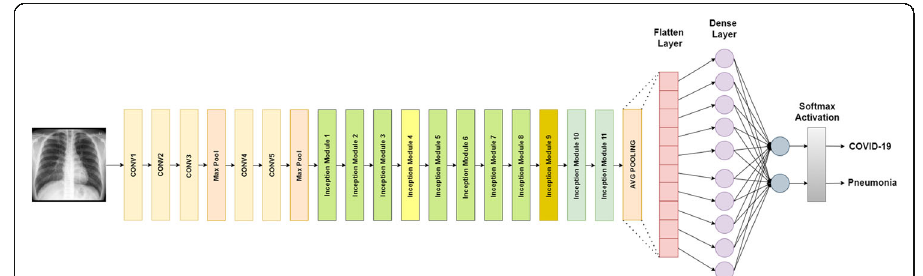
Fig. 5 InceptionV3 architecture designed for binary